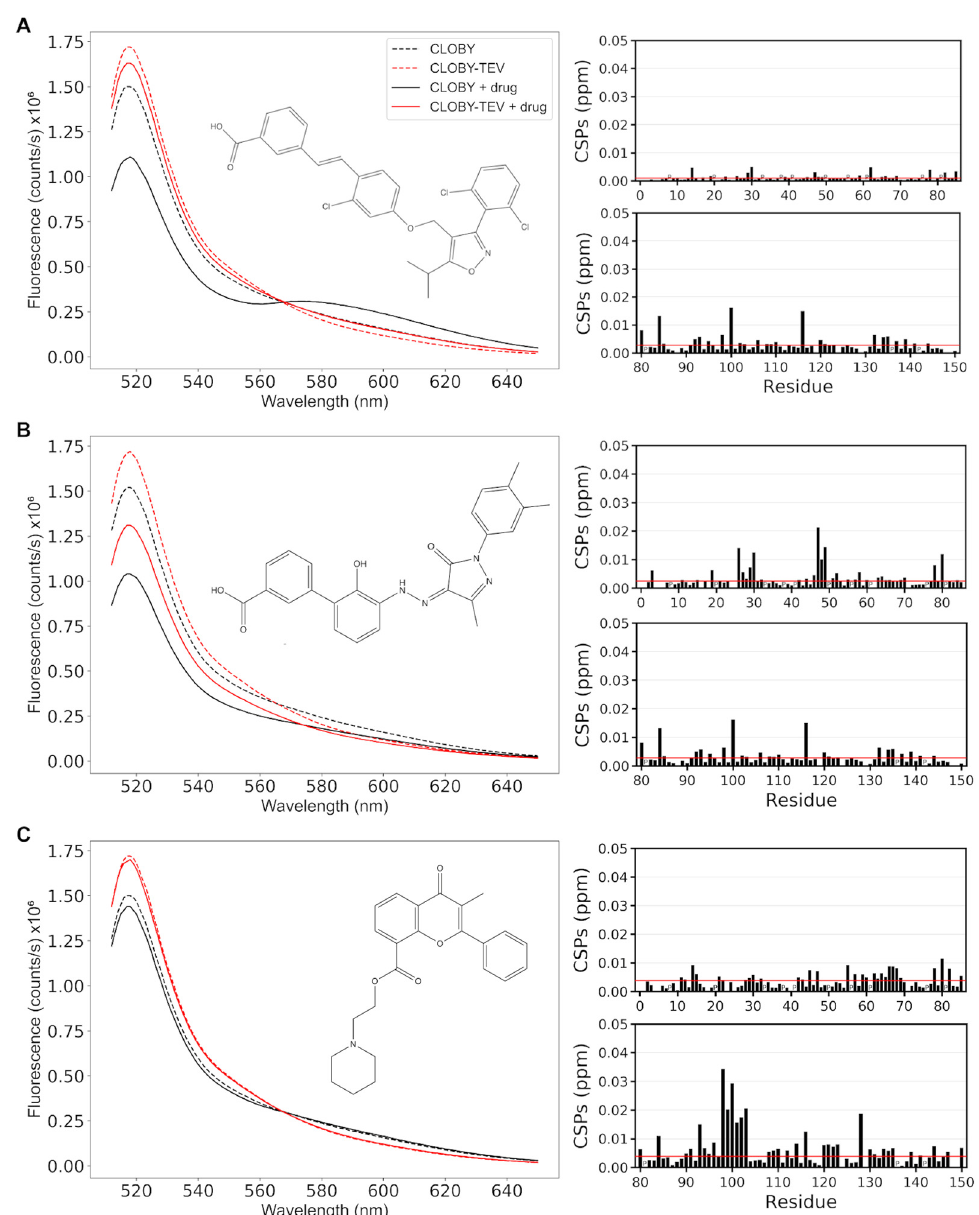
Figure 5. NMR validation of FRET results. Representative results of the three classes of hits defined by comparing fluorescence data and NMR perturbations. In each panel the fluorescence of CLOBY and CLOBY-TEV (at 1 µ M concentration), in the presence or in the absence of excess drug (100 µ M) are shown in the left. Chemical shift perturbations caused by the drug in the isolated SNRE, i.e., in the absence of the fluorescent proteins, are shown in the right. The effect on the disordered region (at 278 K) is shown on top and that that on the SH3 domain (at 298 K) are shown below. ( A ): GW4064; ( B ): Eltrombopag; ( C ): Flavoxate.